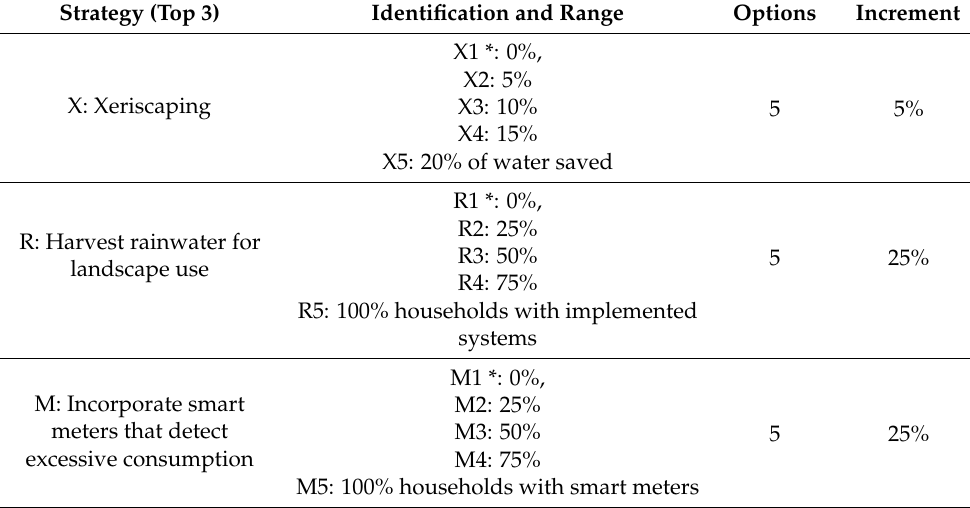
Table 3. Ranges and Intervals of Parameter Variation. Strategy (Top